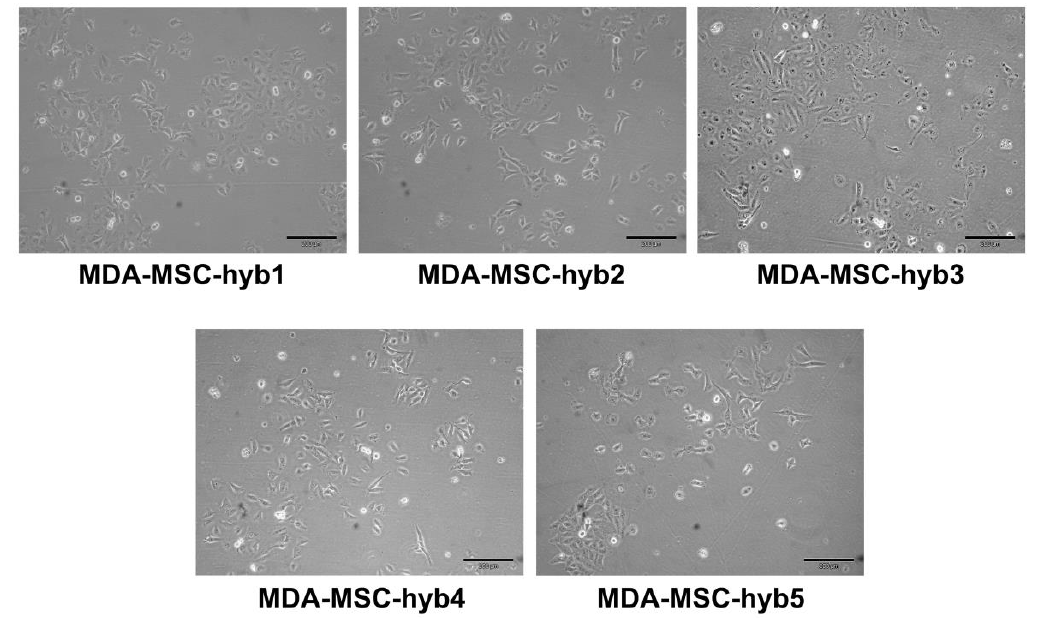
Figure1. Alteredmorphologiesdisplayedbydifferenthybridcancercellsisolatedafterspontaneousfusion of MDA-MB-231 breast cancer cells with human mesenchymal stroma / stem-like cells (MSC)